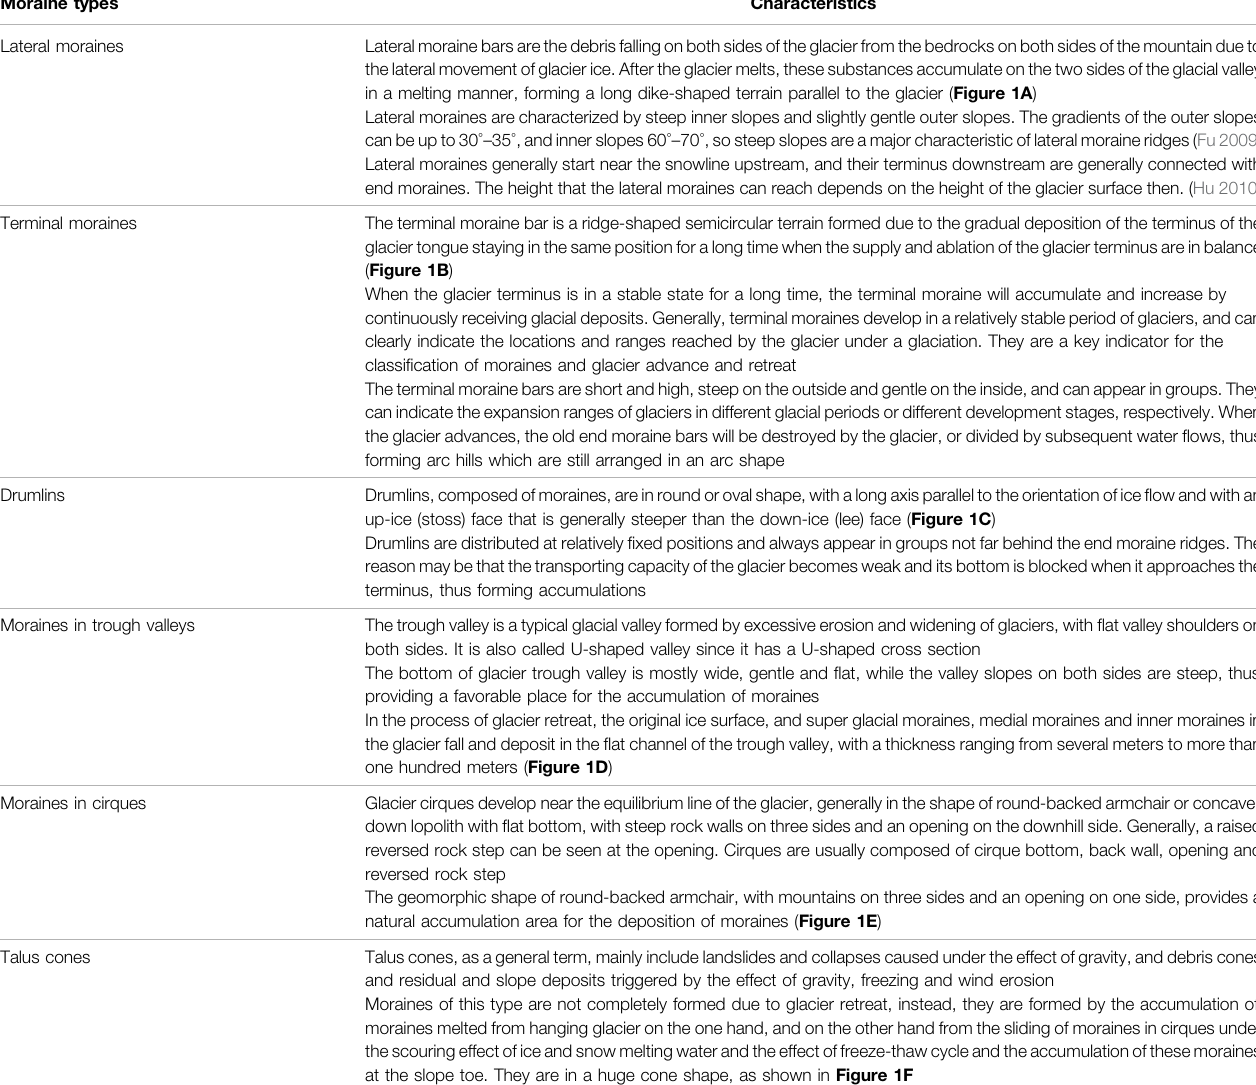
TABLE 1 | Characteristics of different types of